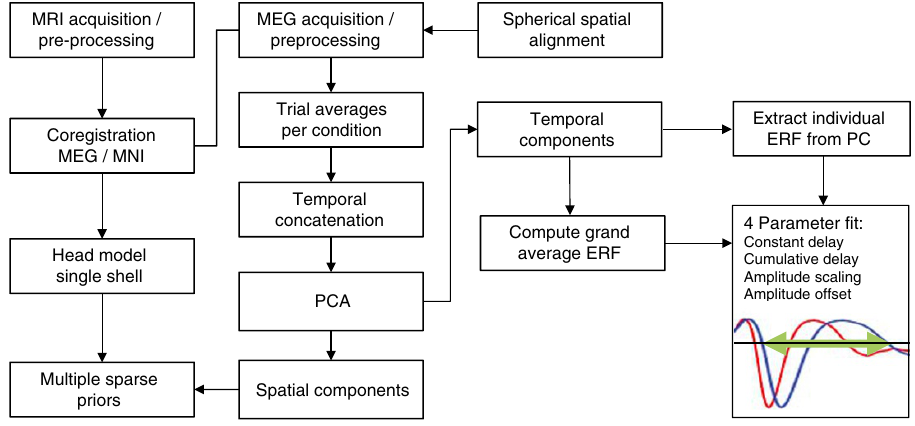
Figure 5 | Flow chart diagram illustrating the processing steps involved in the analysis of MEG